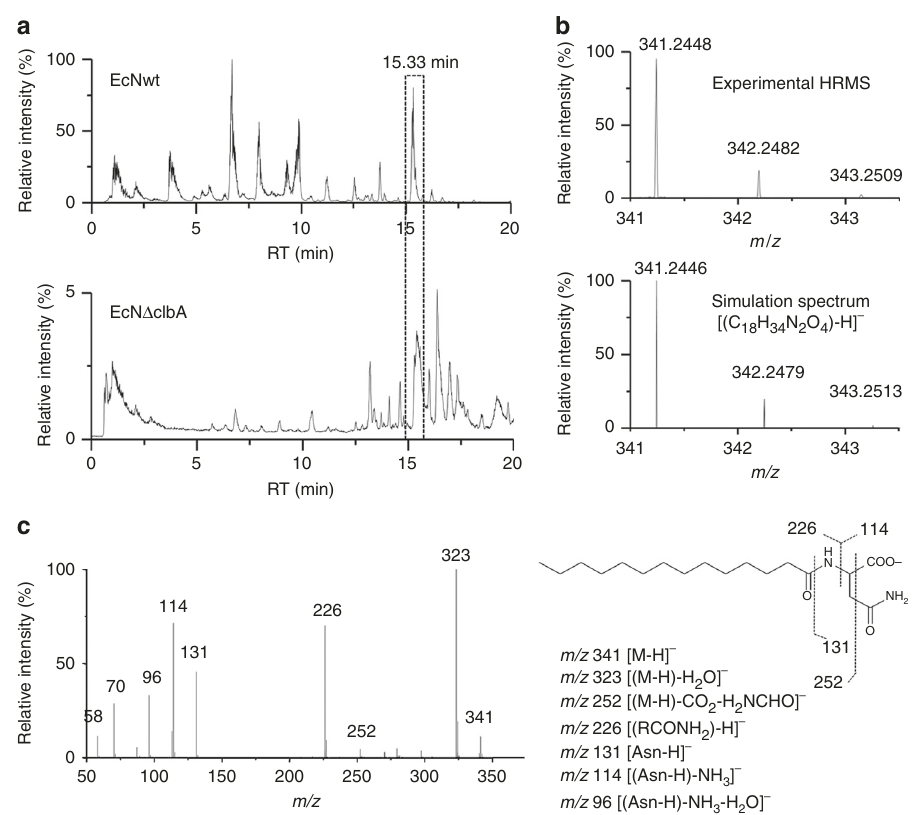
Fig. 2 Characterization of C14-Asparagine (C14Asn OH ) by LC-HRMS. a TIC of a lipidic extract of EcNwt pellet (up) and EcN Δ clbA pellet (down). b Natural isotopic distribution of the deprotonated molecule displayed by the high-resolution mass spectrum zoom obtained for the peak eluted at 15.33 min in both TIC (top) and natural isotopic pattern calculated with the formula [(C 18 H 34 N 2 O 4 )-H] − . Analogous natural isotopic patterns and similar m / z ratios measured and simulated for the monoisotopic [( 12 C 18 1 H 34 14 N 2 16 O 4 )-H] − ion and for the [( 13 C n C 18- n 1 H 34 14 N 2 16 O 4 )-H] − (with n = 1 and 2) ions (within an accuracy of 0.6 ppm). c Product ion spectrum acquired via HCD (NCE = 35%) of the carboxylate anion [M – H] − ( m / z 341) generated in electrospray from the LC peak eluted at 15.33 (Supplementary Fig. 2b) re fl ects the consecutive CO 2 and HCONH 2 losses, the free functional groups of the